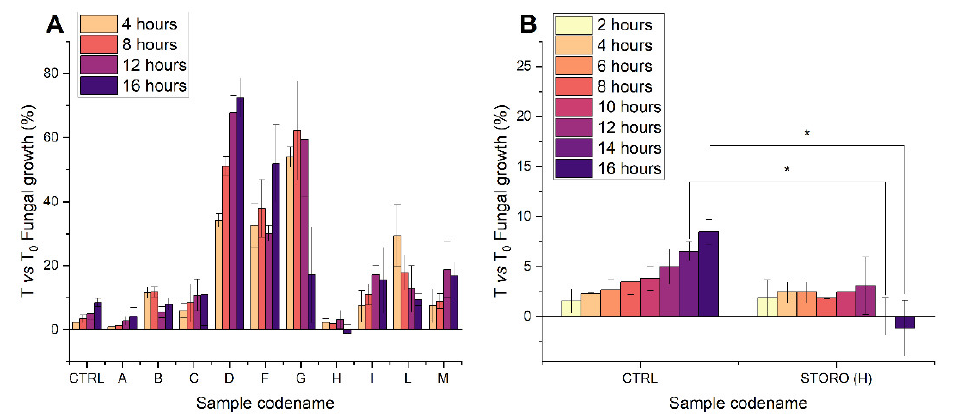
Figure 2. F. verticilloides fungal growth in presence of imbibition media of selected maize local varieties, grown in the same fields ( A ). Data are reported as % absorbance increase at each timepoint with respect to initial timepoint ± standard deviation. ( B ) Reports the investigation at closer timepoints of fungal growth in presence of sample H (Nostrano di Storo maize local variety) in comparison with a control sample where the same amount of fungal conidial were incubated without any maize imbibition medium. Statistical significance was assessed with ANOVA test * p < 0.01.